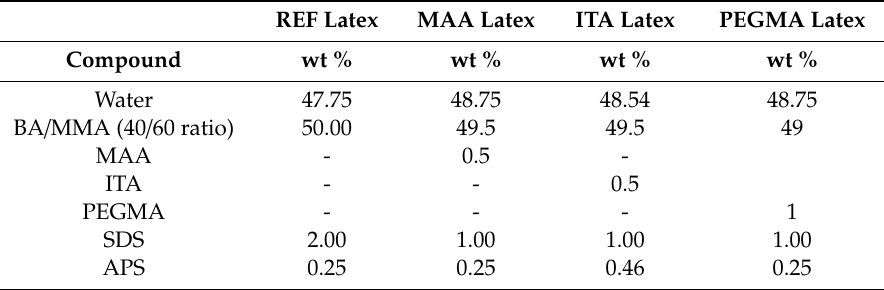
Table 1. Formulation of the di ff erent